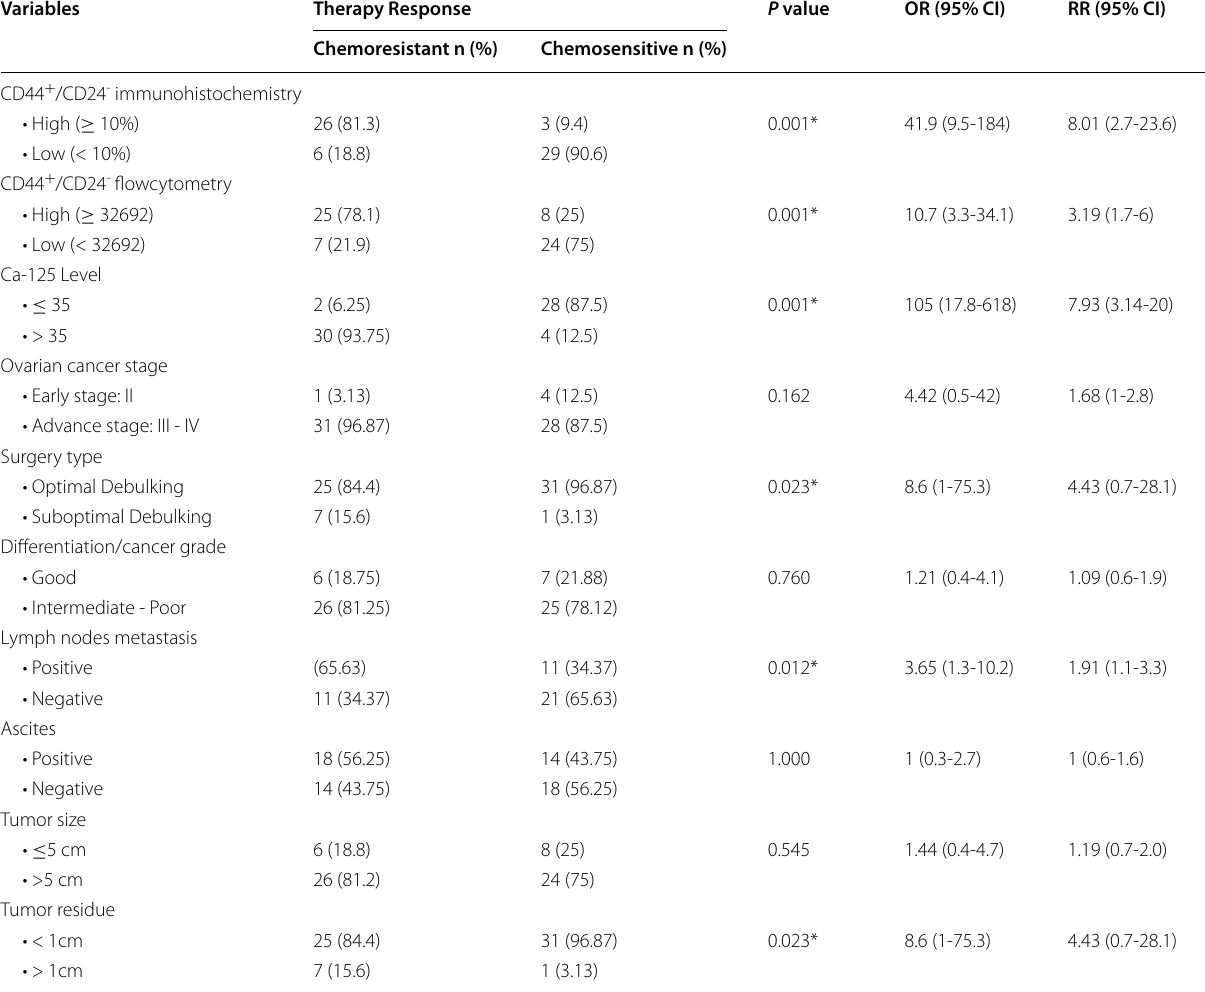
* p <0.05, significant results